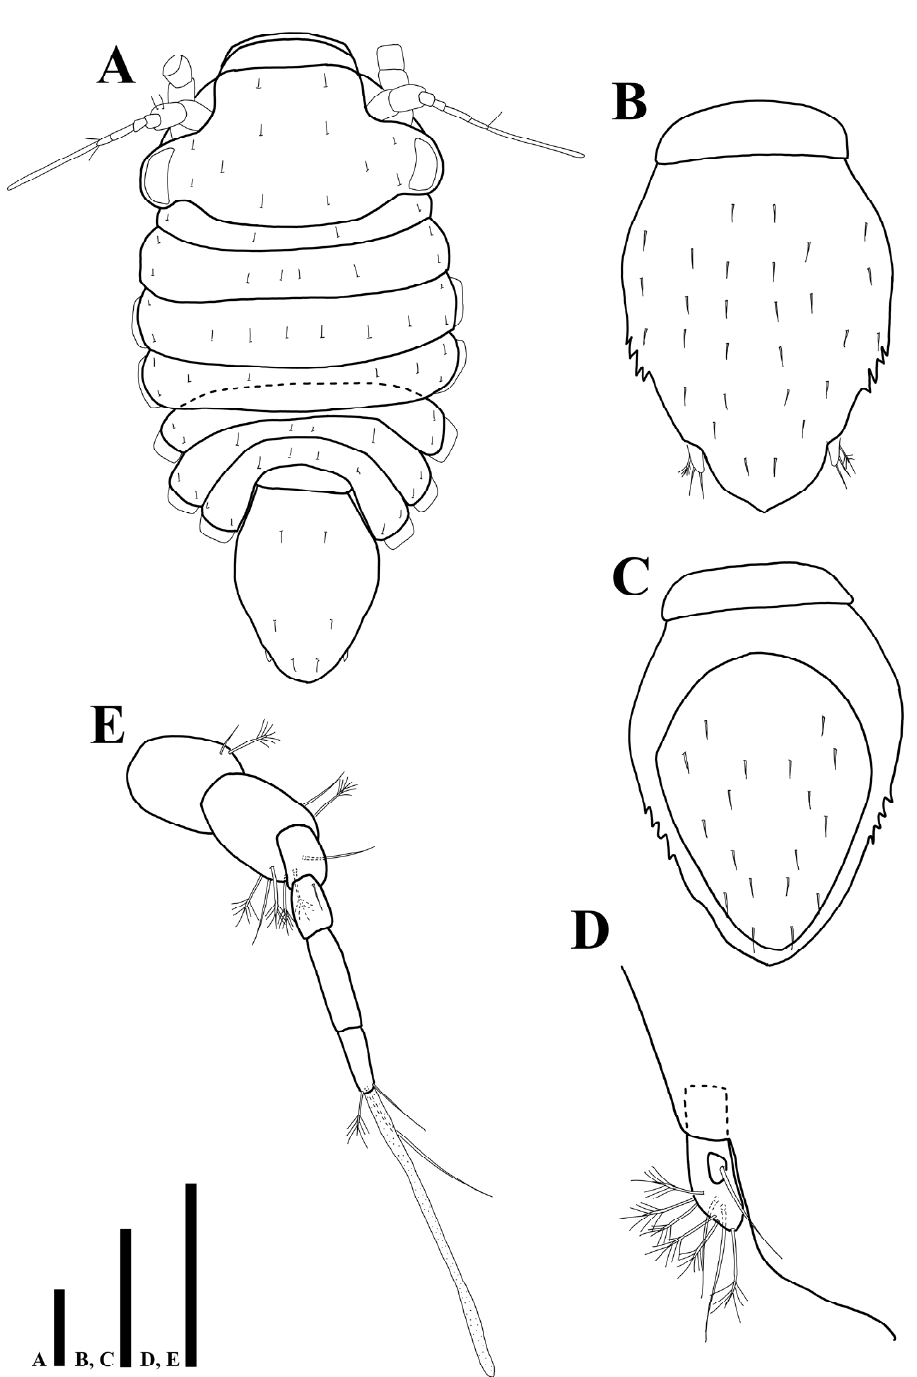
Body (Figure 14A): total length 800 µ m, 1.9 times longer than wide.